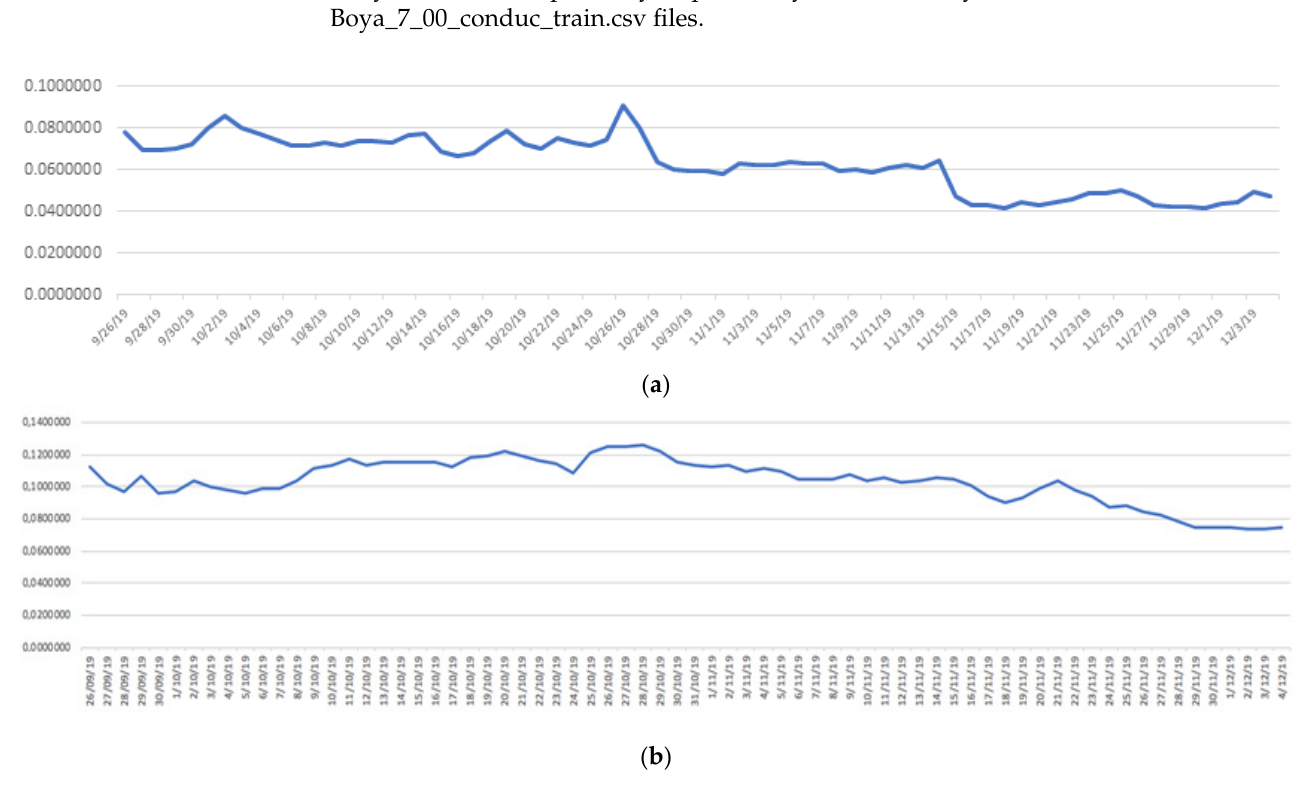
Figure 5. ( a ) Conductivity measurement on Buoy 3. ( b ) Measurement of conductivity in Buoy